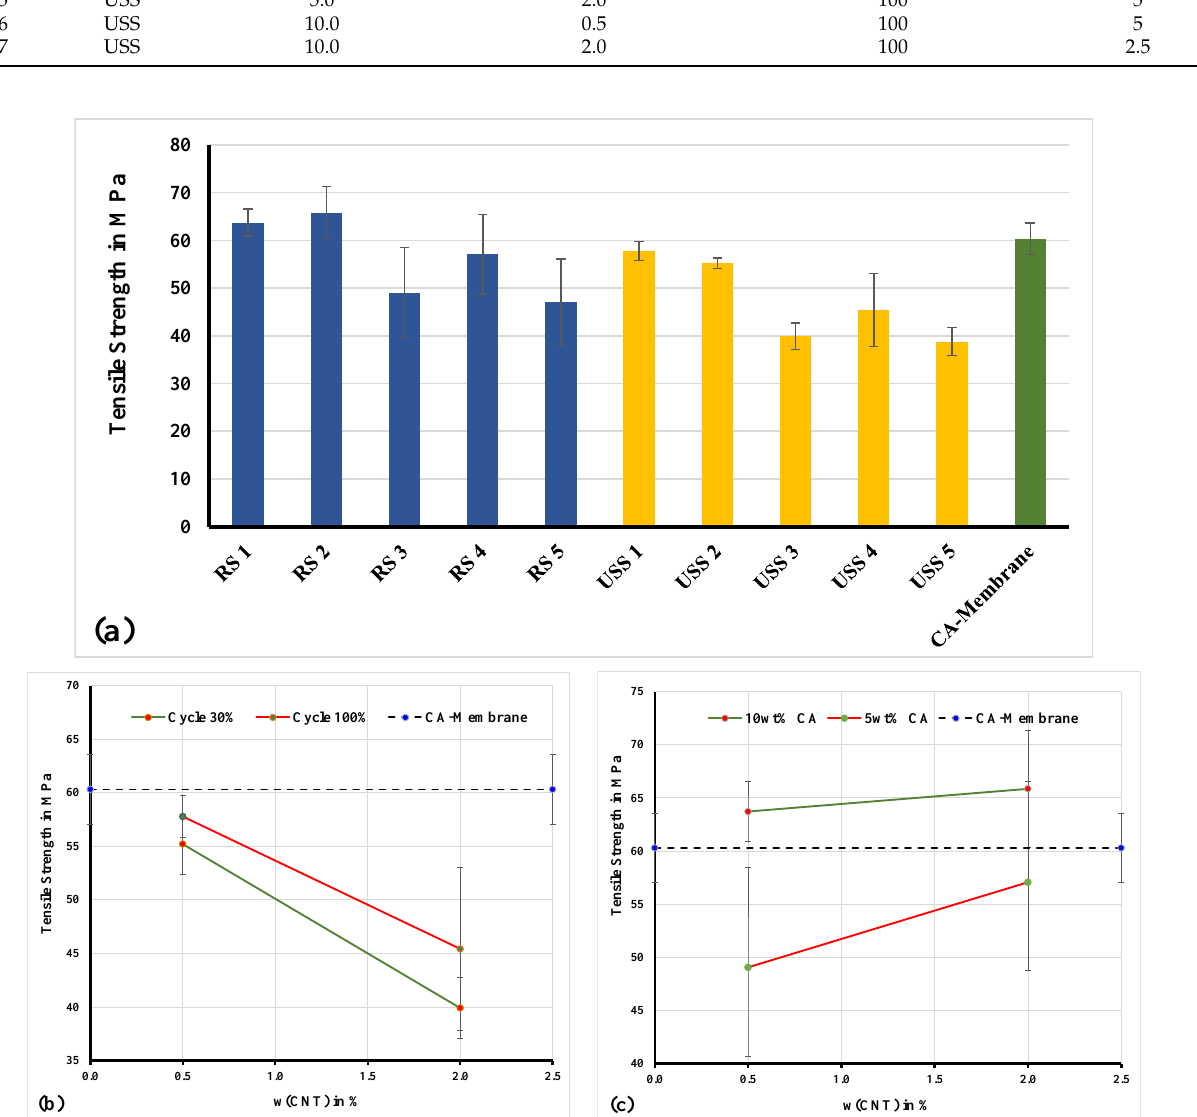
Figure 6. Mechanical analysis—( a ) ultimate tensile strength of samples from Table 4. ( b ) Effect of MWCNTs concentration on tensile strength of membranes prepared by ultrasonification (USS). ( c ) Effect of MWCNTs concentration on tensile strength of membranes prepared by rotor-stator (RS).